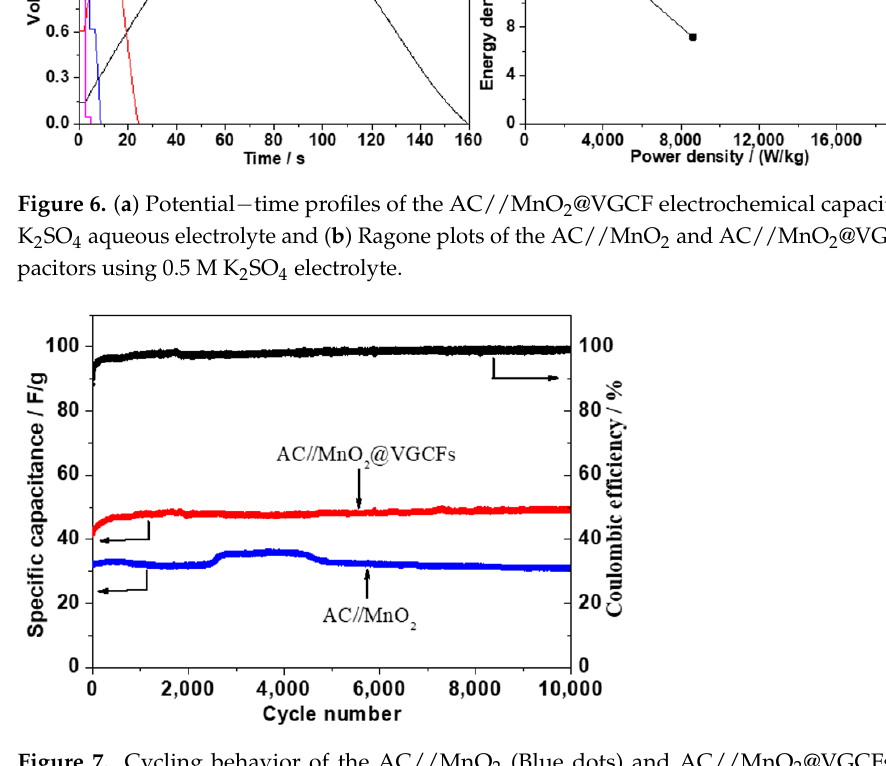
Figure 7. Cycling behavior of the AC//MnO 2 (Blue dots) and AC//MnO 2 @VGCFs (red dots) supercapacitors at 1000 mA g − 1 (black dots refer to Coulombic efficiency).